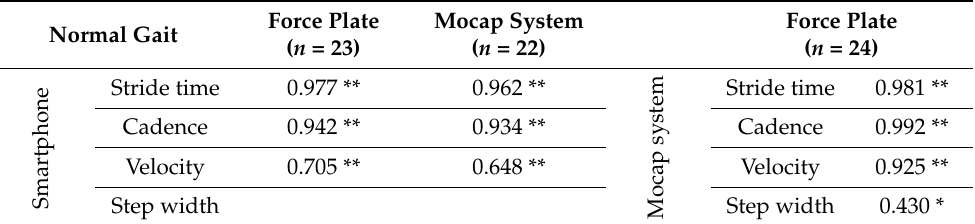
Table 5. Between-system correlations for normal gait between the force plate, mocap system and smartphone at T1 (first measurement time). Correlation after Pearson. Normal Gait